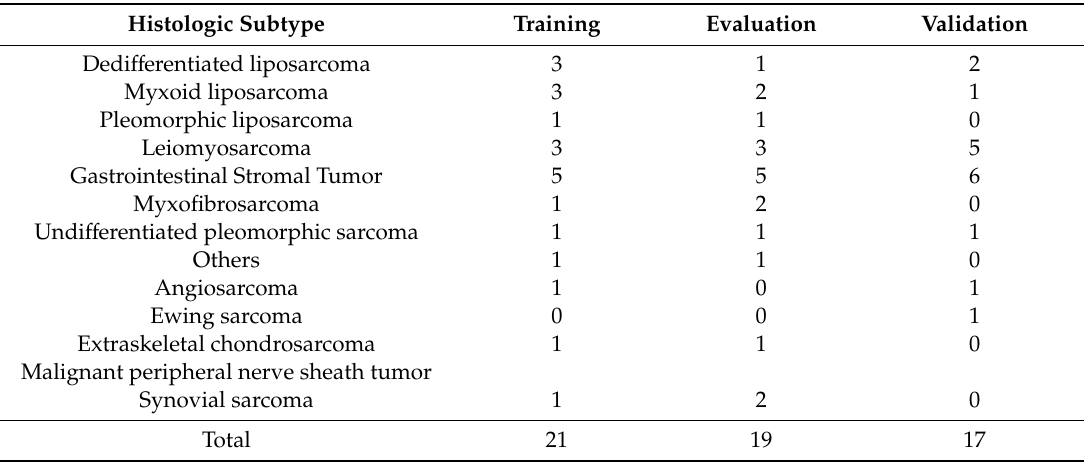
Table 2. Overview of histologic subtypes of the included sarcoma patients. Distribution of the di ff erent histologic subtypes of sarcoma patients between the training, evaluation and validation